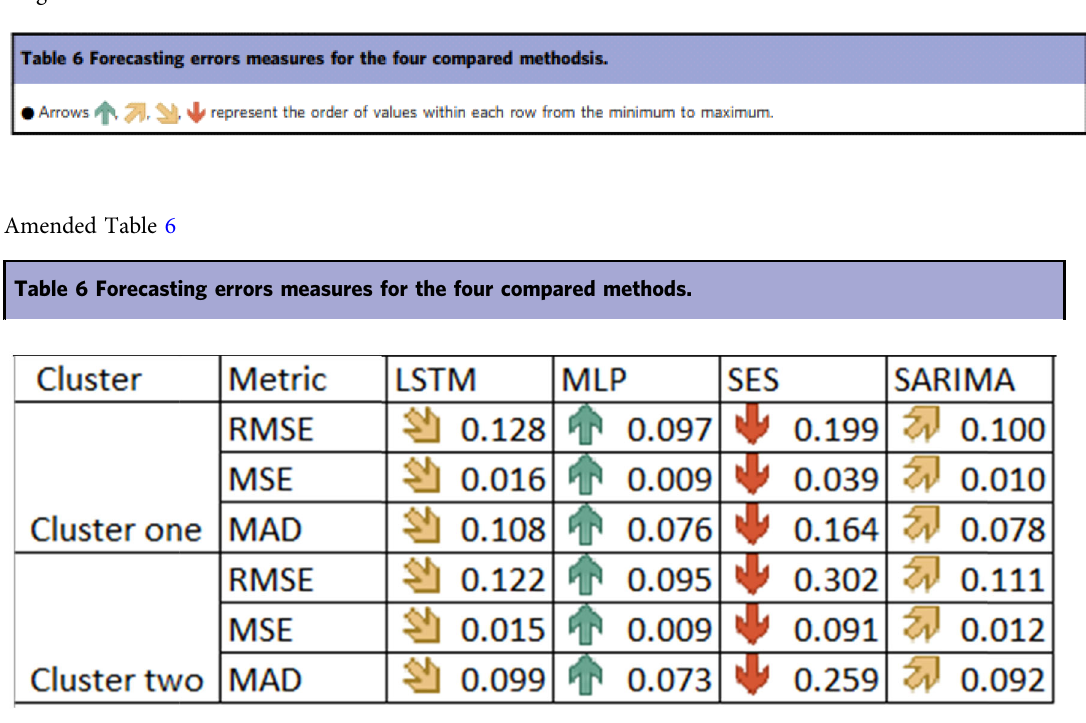
Arrows represent the order of values within each row from the minimum to